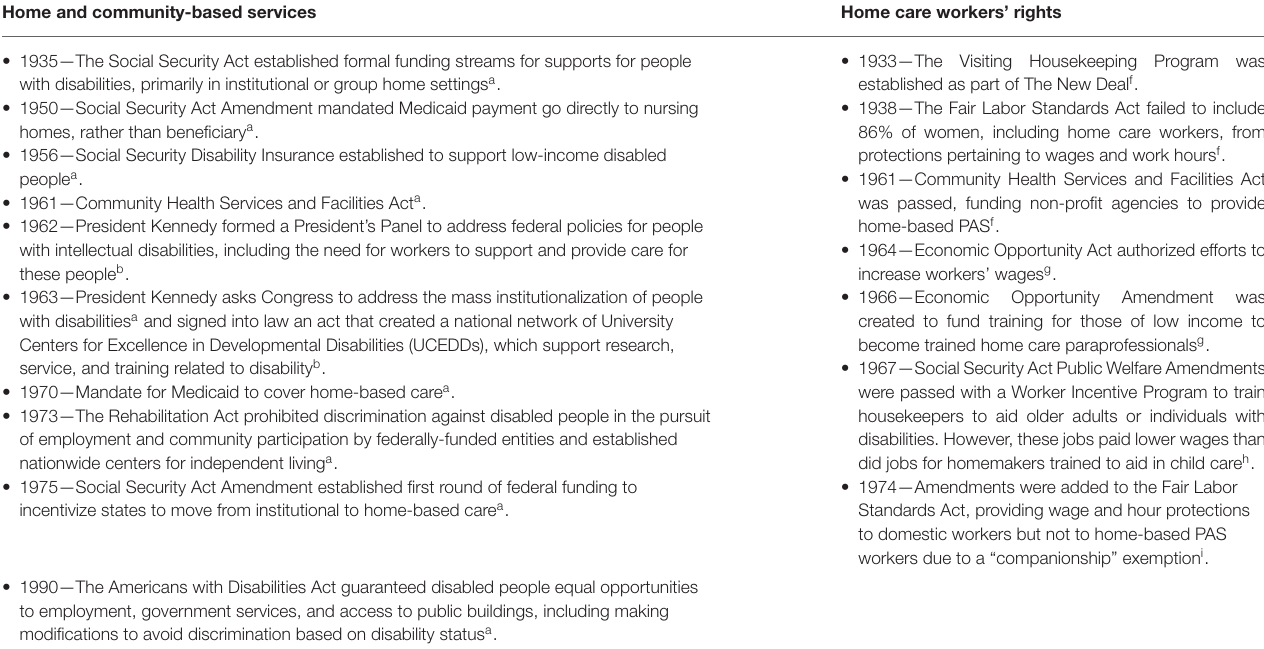
TABLE 1 | Evolution of federal policies related to personal assistance services and home care workers’